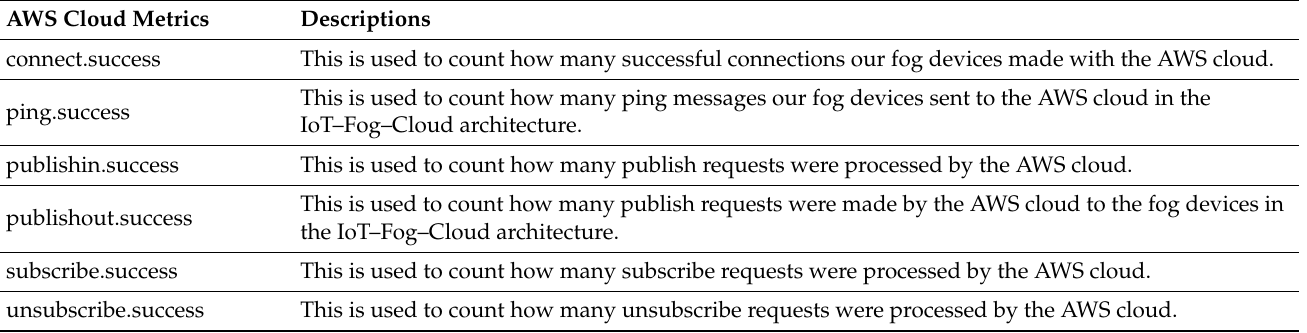
Table 2. Descriptions of AWS cloud